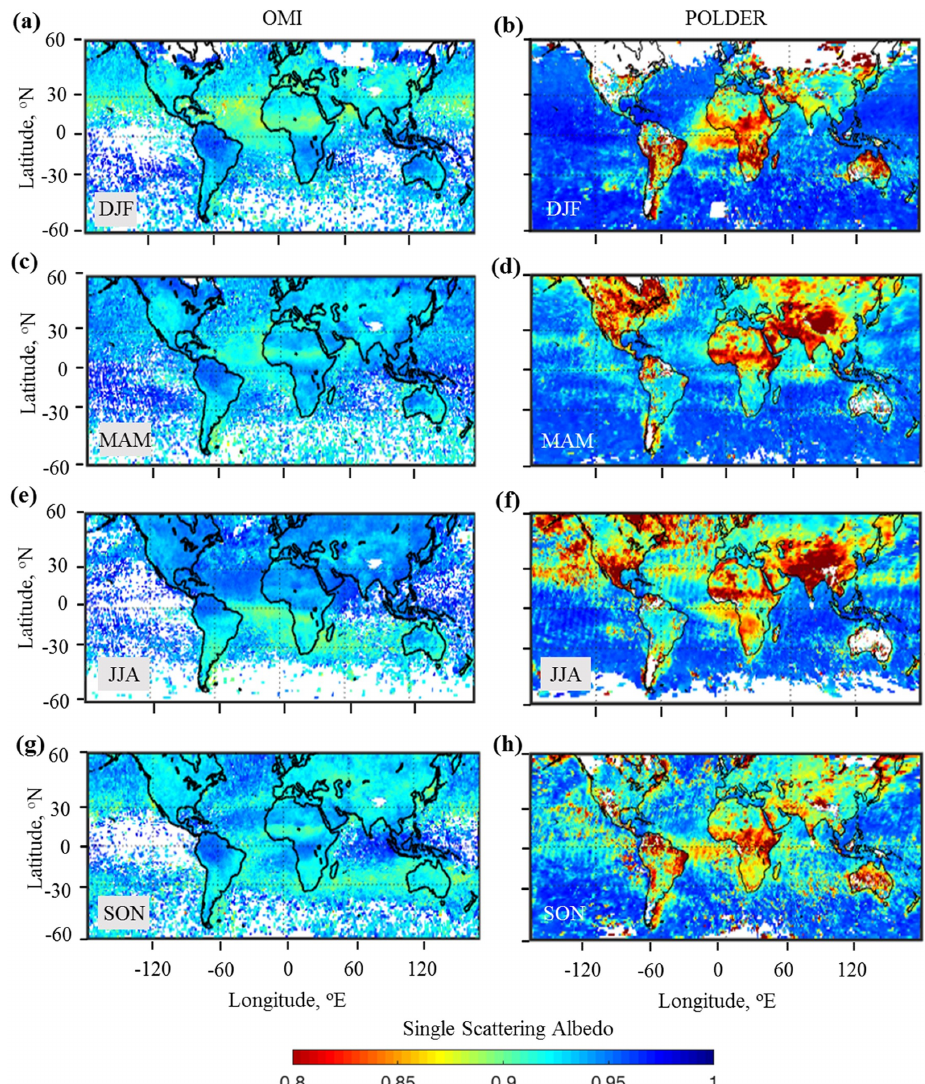
Figure 5. Seasonal mean SSA maps of OMI (500nm) in panels (a) , (c) , (e) , (g) and POLDER (565nm) in panels (b) , (d) , (f) , (h) , for (a, b) December–January–February (DJF), (c, d) March–April–May (MAM), (e, f) June–July–August (JJA), (g, h) September–October–November